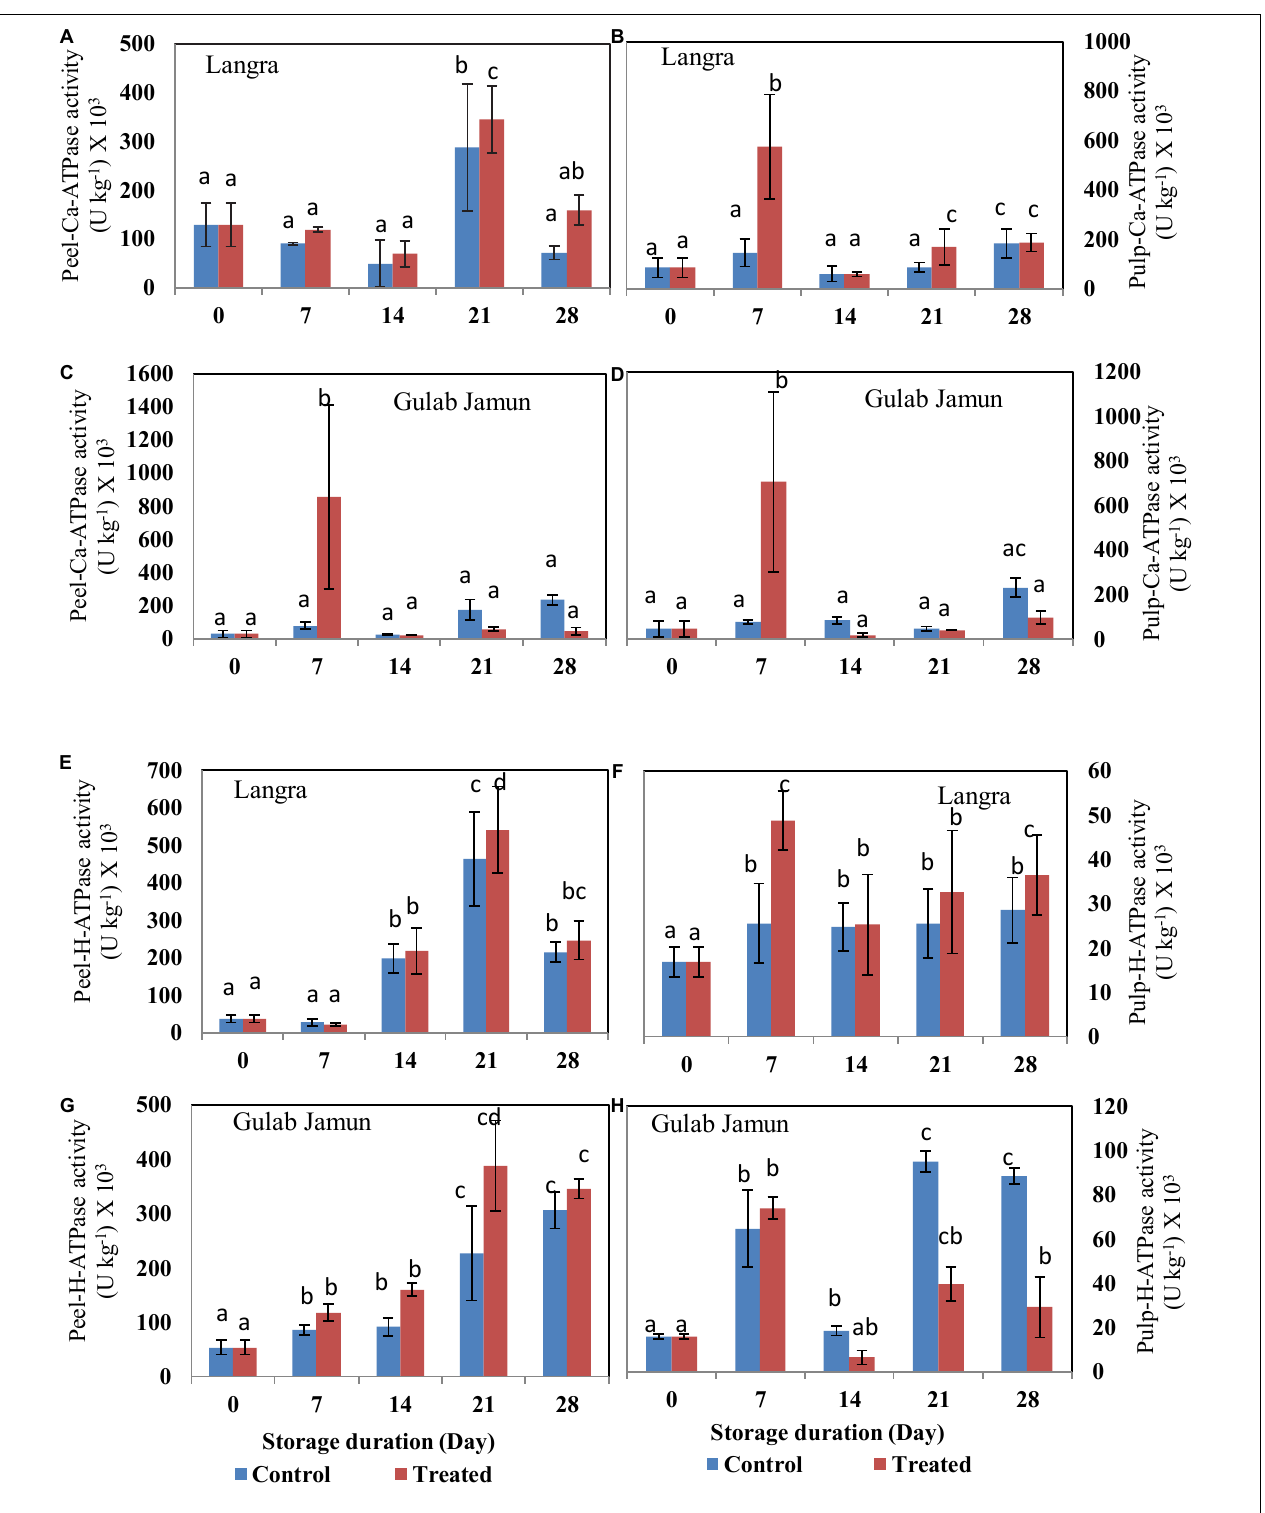
FIGURE 5 | Ca 2 + -ATPase activity in (A) ‘Langra’ peel, (B) ‘Langra’ pulp, (C) ‘Gulab Jamun’ peel, and (D) ‘Gulab Jamun’ pulp and H + -ATPase activity in (E) ‘Langra’ peel, (F) ‘Langra’ pulp, (G) ‘Gulab Jamun’ peel and (H) ‘Gulab Jamun’ pulp treated with 0 µ M (control) or 100 µ M (treated) MT for 2 h, followed by 28 days of storage at 5 ± 1 ◦ C and 3 days of shelf life at room temperature (25 ◦ C, 90–95% RH). Measurements were taken on every 7 days of storage. Each value is the mean of three replicates ± standard error. Error bars with different small letters on the same storage period show a significant difference ( P ≤